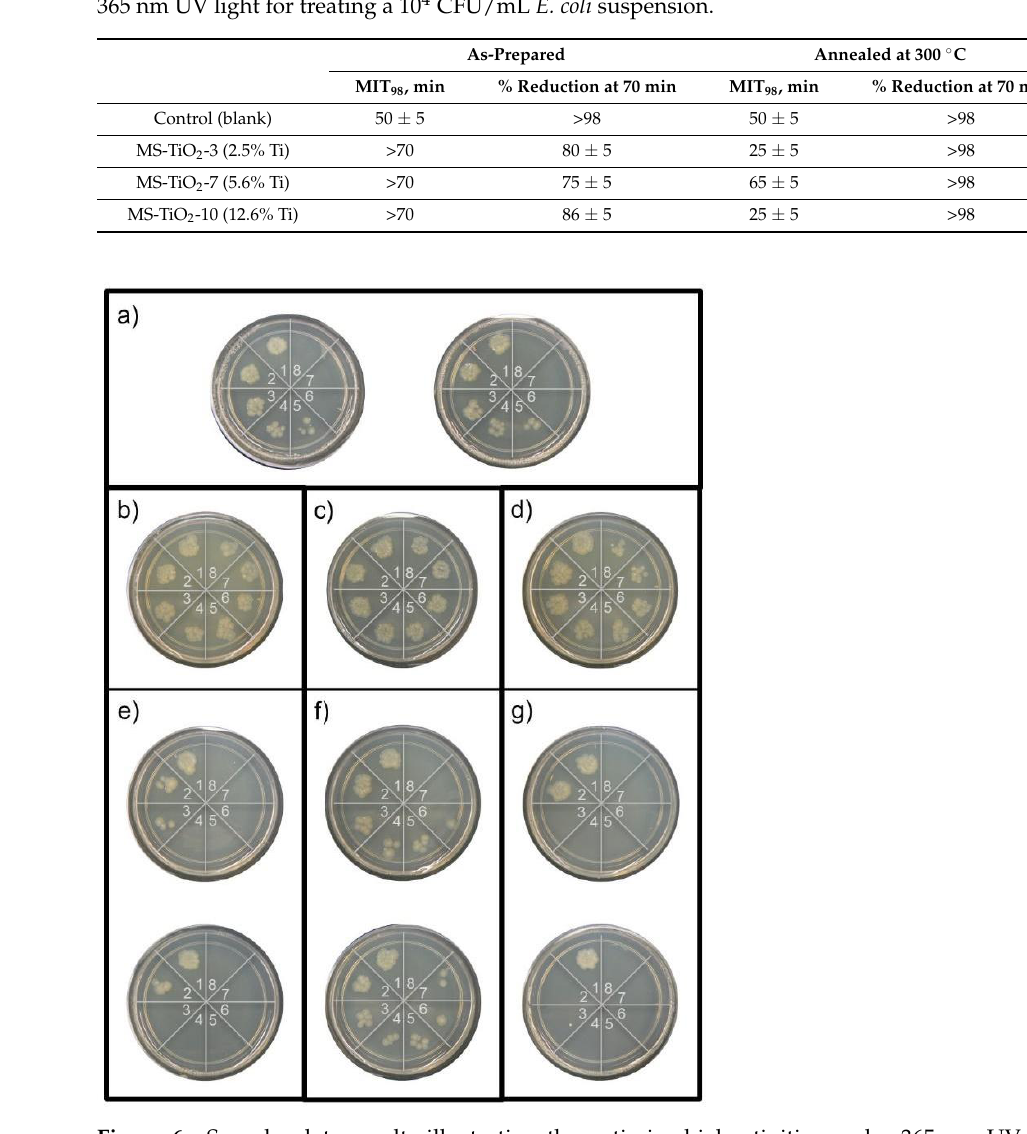
Figure 6. Sample plate results illustrating the antimicrobial activities under 365 nm UV light ( a ) without the presence of nanocomposite, and with the presence of the 30 mg/mL of ( b ) as-prepared MS-TiO 2 -3, ( c ) as-prepared MS-TiO 2 -7, ( d ) as-prepared MS-TiO 2 -10, ( e ) annealed MS-TiO 2 -3, ( f ) an- nealed MS-TiO 2 -7, ( g ) annealed MS-TiO 2 -10 nanocomposite against E. coli in a suspension containing 10 4 CFU/mL. Note: 1 = untreated, 2, 3, 4, 5, 6, 7, 8 = after 10, 20, 30, 40, 50, 60, 70 min treatments, respectively. The samples contained 2.5, 5.6, and 12.6 wt.% Ti for MS-TiO 2 -3, MS-TiO 2 -7, and MS-TiO 2 -10, respectively. Table 2. The antimicrobial activities of the as-prepared and annealed MS-TiO 2 nanocomposites un- der 365 nm UV light for treating a 10 4 CFU/mL E. coli suspension.